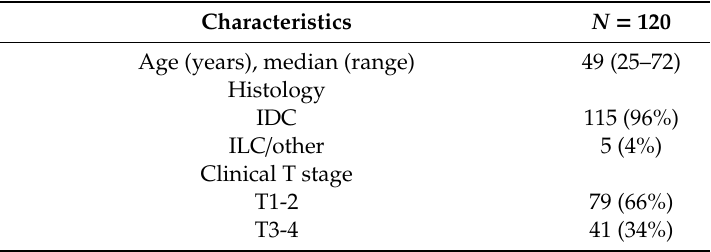
Figure 3. Patient flow. NAC: neoadjuvant chemotherapy; VOI: volume of interest; SUVmax: maximum standardized uptake value. Table 1. Patient and tumor characteristics.